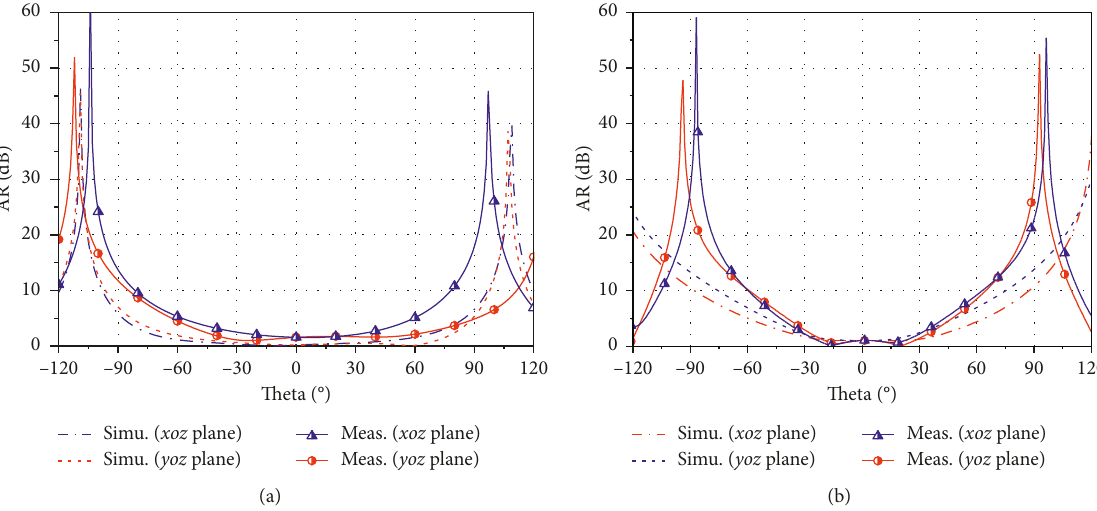
Figure 17: Measured and simulated AR as a function of elevation angle in xoz and yoz planes. (a) 1.207GHz. (b)